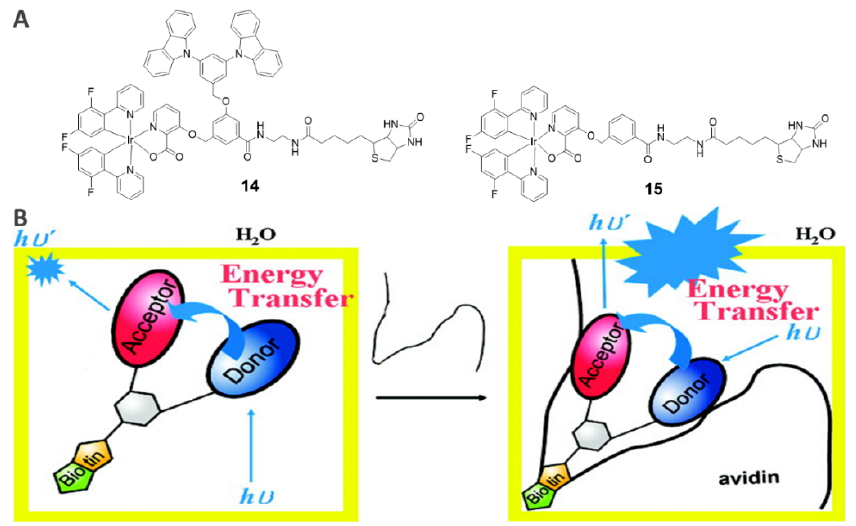
Figure 10. ( A ) Chemical structures of complexes 14 − 15 . ( B ) Schematic illustration of complex 14 to detect avidin. Reproduced with permission from ref. [80]. Copyright 2008 American Chemical Society.